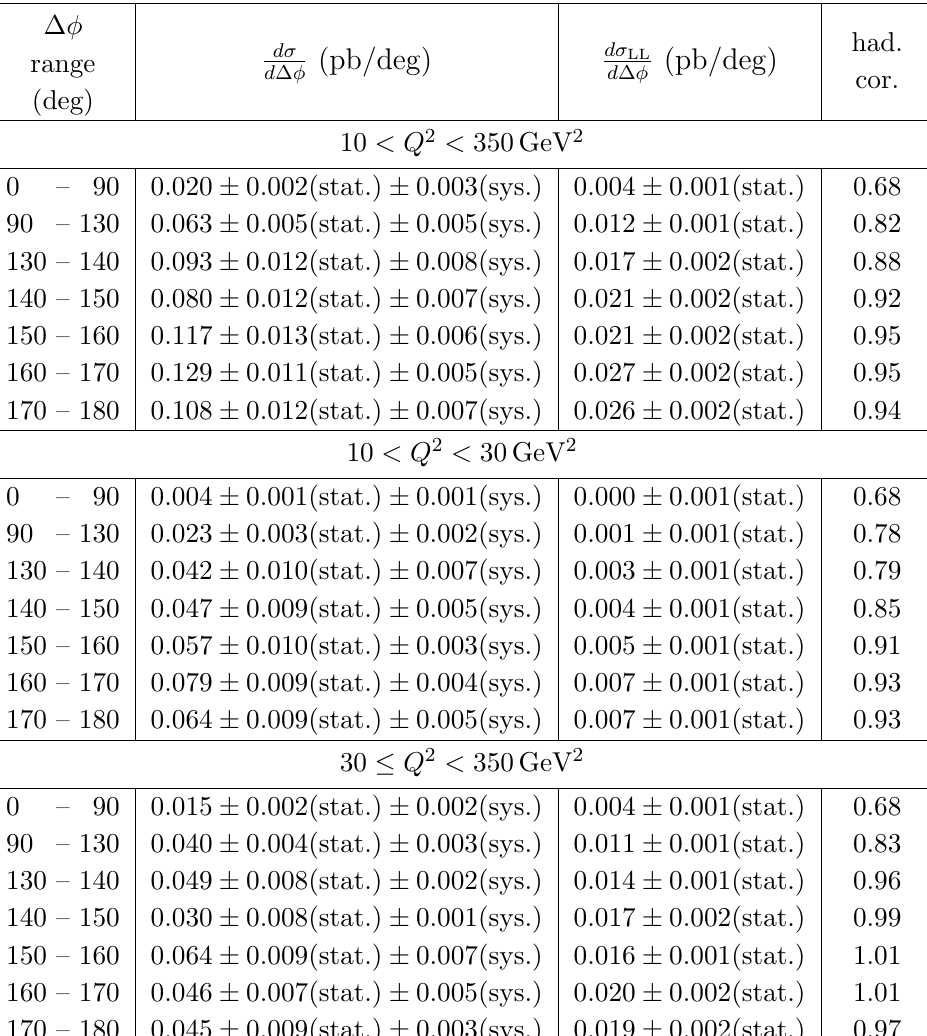
Table 3 . Measured di(cid:11)erential cross-section d(cid:27)